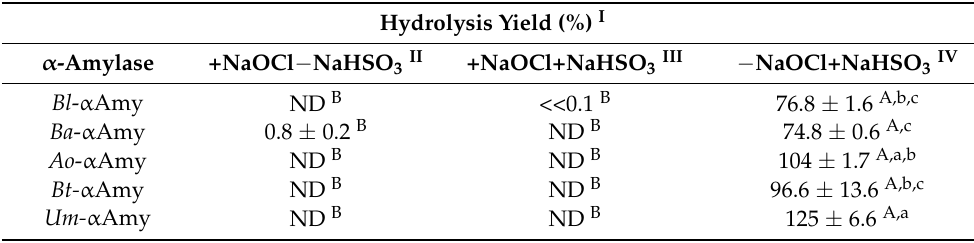
Table 3. Inactivation test of five α -amylases using 7 mM NaOCl. I ratio between the reducing sugar concentration in supernatants of 15% raw potato starch samples incubated for 16 h with α -amylase in the presence of NaOCl, NaHSO 3 or both (S), and the respective controls (C)—i.e., the reducing sugar concentration in supernatants of starch incubated with each of the five α -amylases in the presence of neither NaOCl nor NaHSO 3 —calculated as follows: hydrolysis yield (%) = S/C × 100. II treatment with 7 mM NaOCl for 5 min at room temperature followed by the reduction of NaOCl with NaHSO 3 (7 mM) and direct incubation, III presence of NaOCl during incubation, IV presence of NaHSO 3 during incubation. ND: not detectable. Different superscript letters A,B and a–c in each row and Table 4. I Reducing sugar concentration (µM) of 15% raw potato starch treated with 11 µg mL − 1 (~190 column, respectively, indicate significantly different hydrolysis yields at p < 0.05 (one-way ANOVA, nM) Bl- α Amy for 0.5–4 h. II samples inactivated by multistep washing only. III samples inactivated based on the Tukey–Kramer statistical comparison test). by NaOCl (7 mM) before the washing procedure. Different superscript letters A,B and a–d in each row and column, respectively, indicate significantly different reducing sugar concentrations at p < 0.05 (one-way ANOVA, based on the Tukey–Kramer statistical comparison test).